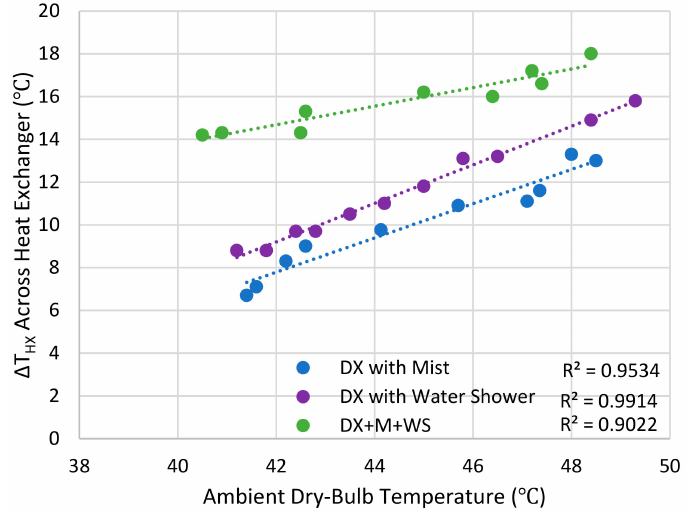
Figure 9. Variation with dry-bulb temperature of ∆ T HX across heat exchanger for ambient temperatures higher than 40 ◦ C.